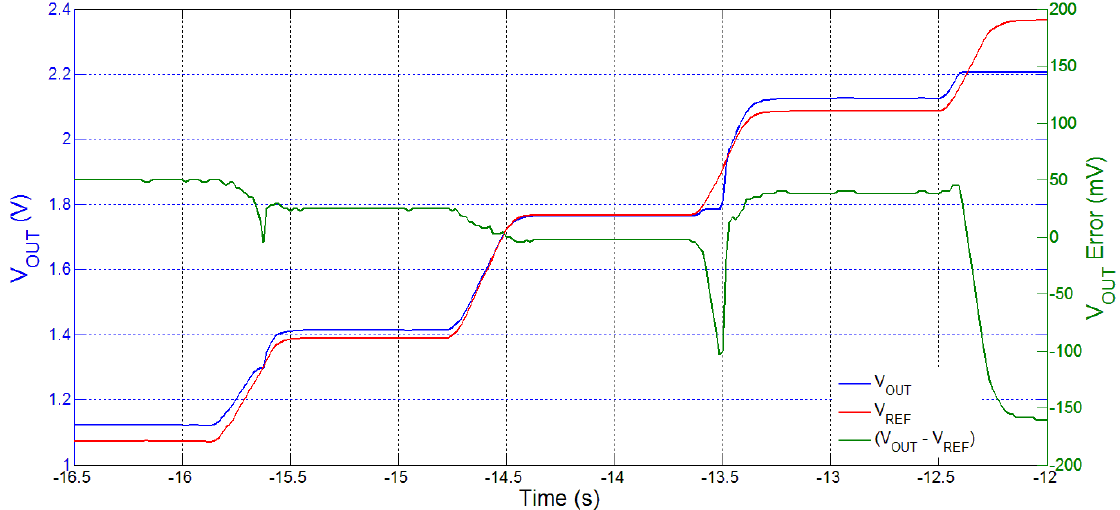
Figure 8. Measurement plot showing voltage tracking of V